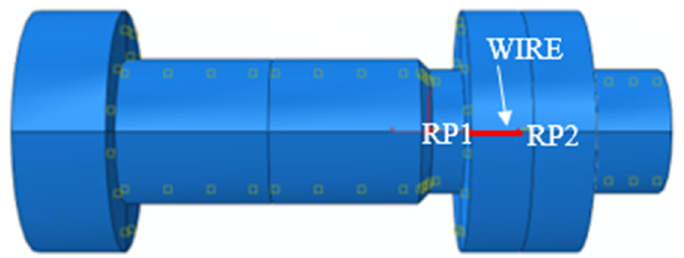
Figure 6. Axial spring connecting the reference points RP1 and RP2.